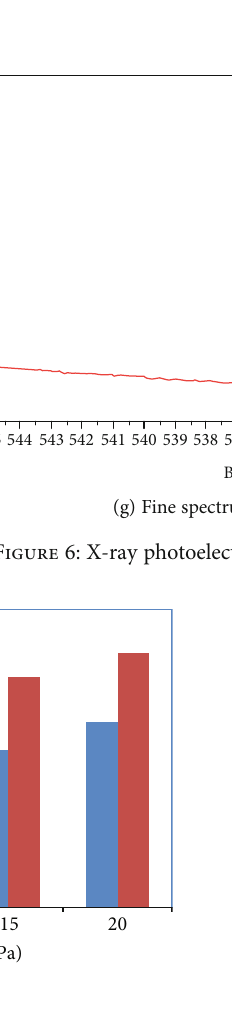
Figure 7: Permeability changing with pressure after CO